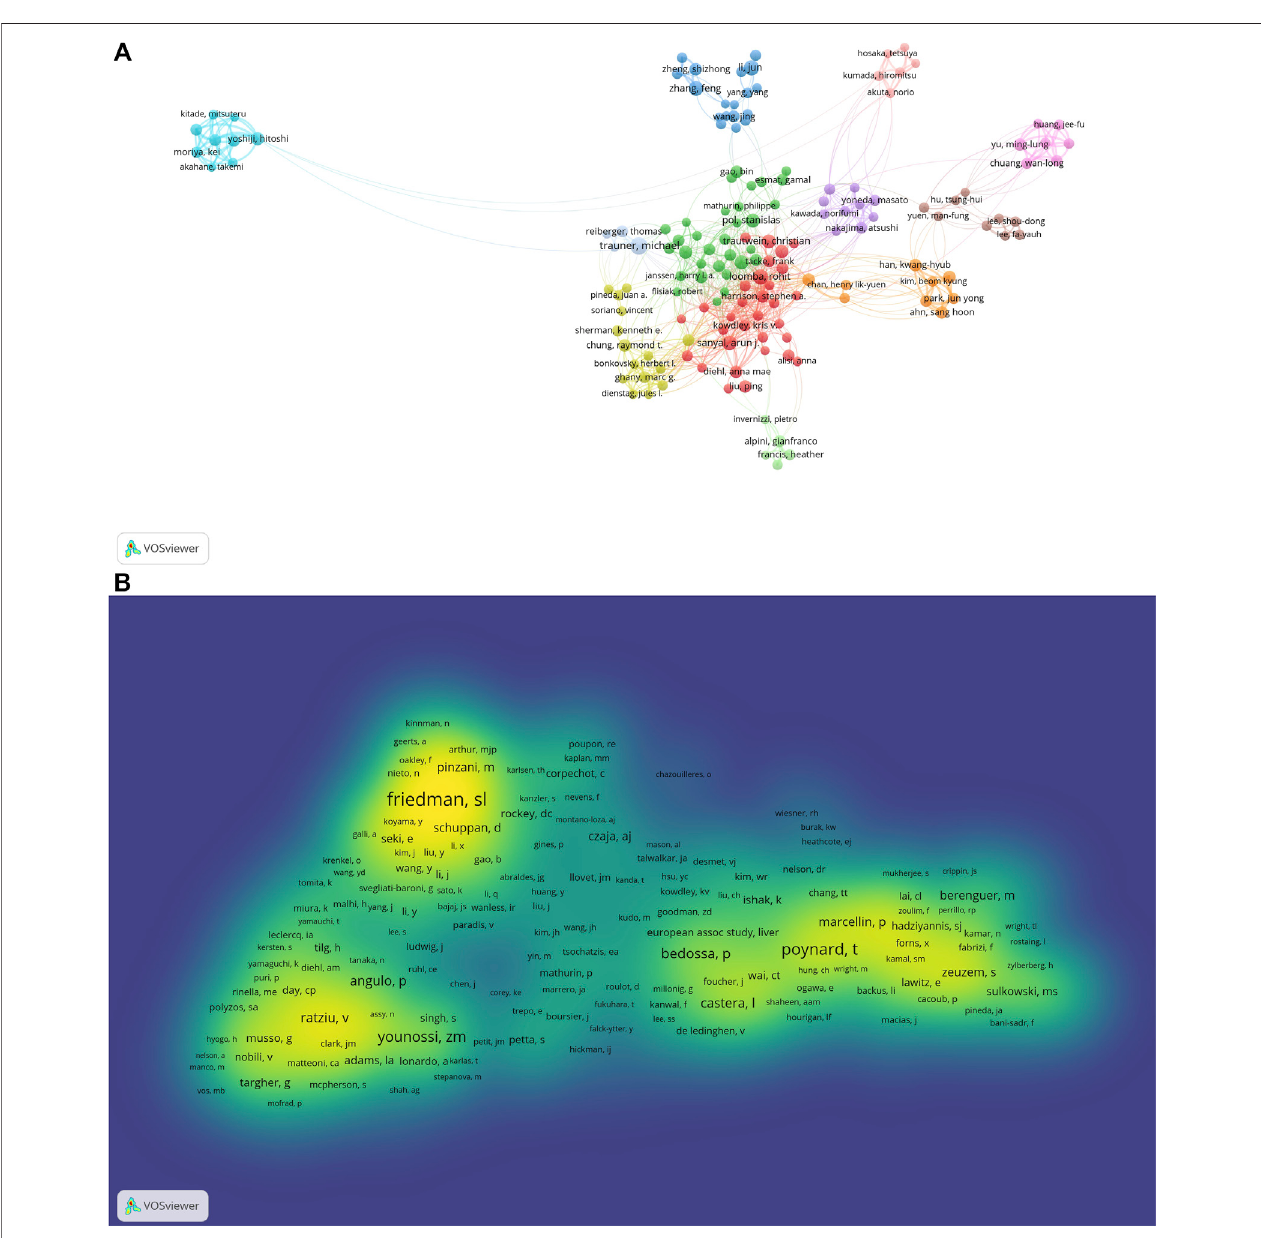
FIGURE 6 | The co-occurrence maps in the treatment of liver fi brosis (A) Authors; (B) Co-authors. Notes: The size of node indicates the author ’ s co-occurrence frequencies while its different colors re fl ect different clusters, and the links re fl ect the co-occurrence relationship between authors (Map A). The size of word and round, and the opacity of yellow are positively associated with the co-cited frequency (Map B).jpg.